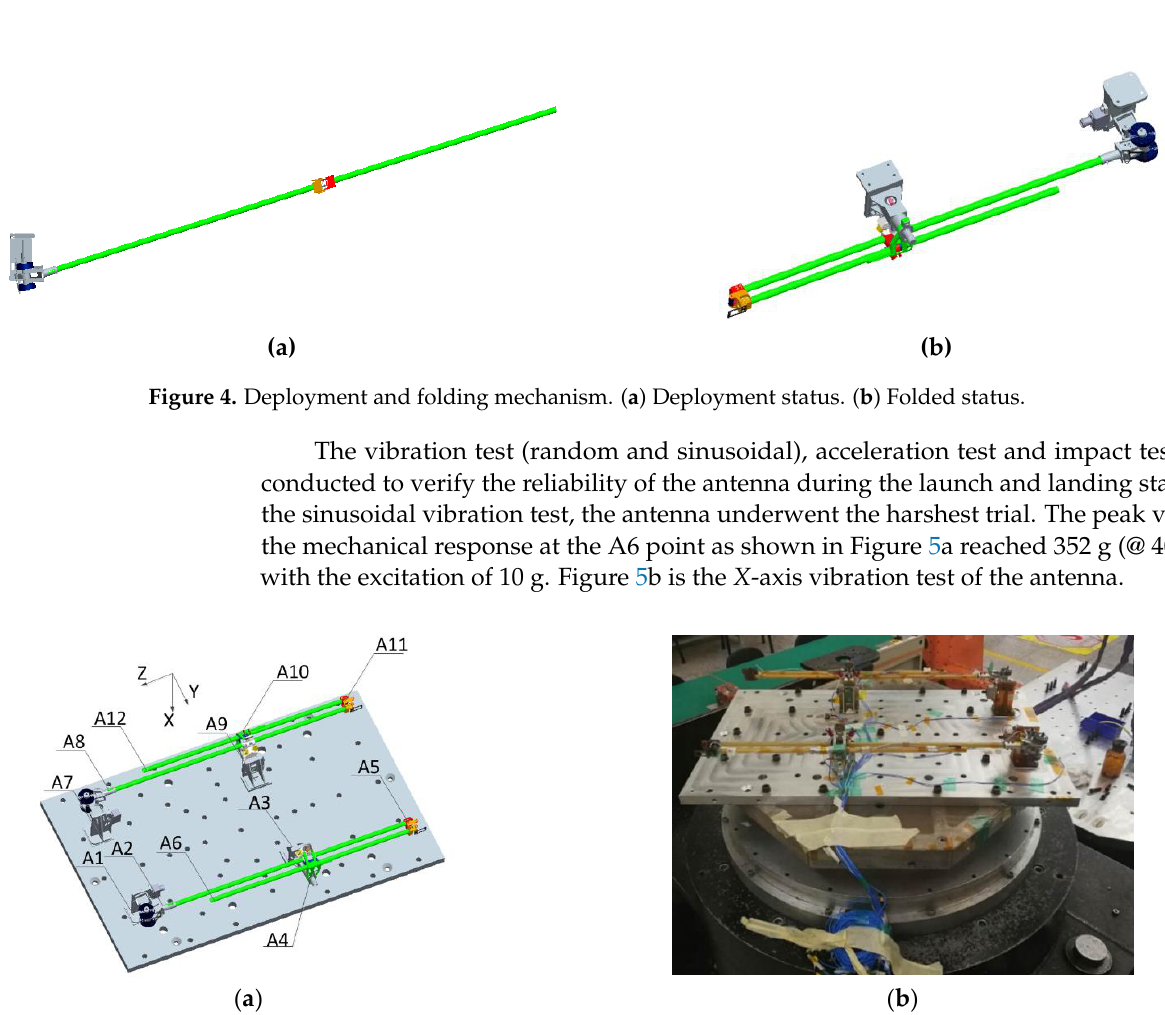
Figure 5. Mechanical test status. ( a ) Distribution of response points. ( b ) X -axis vibration test status.